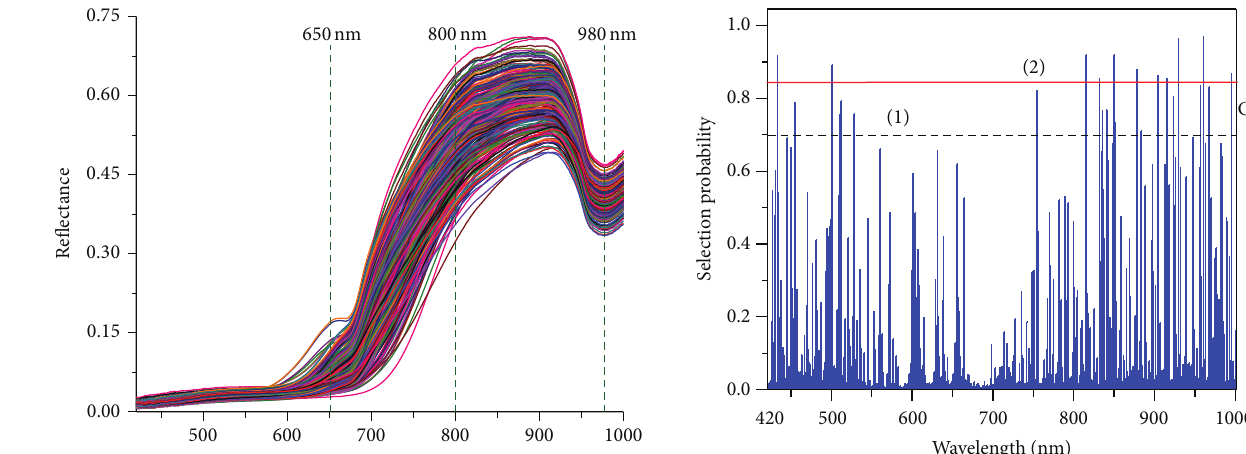
Figure 5: Spectral curves of all mulberries covering the range of 420–1,000 nm.